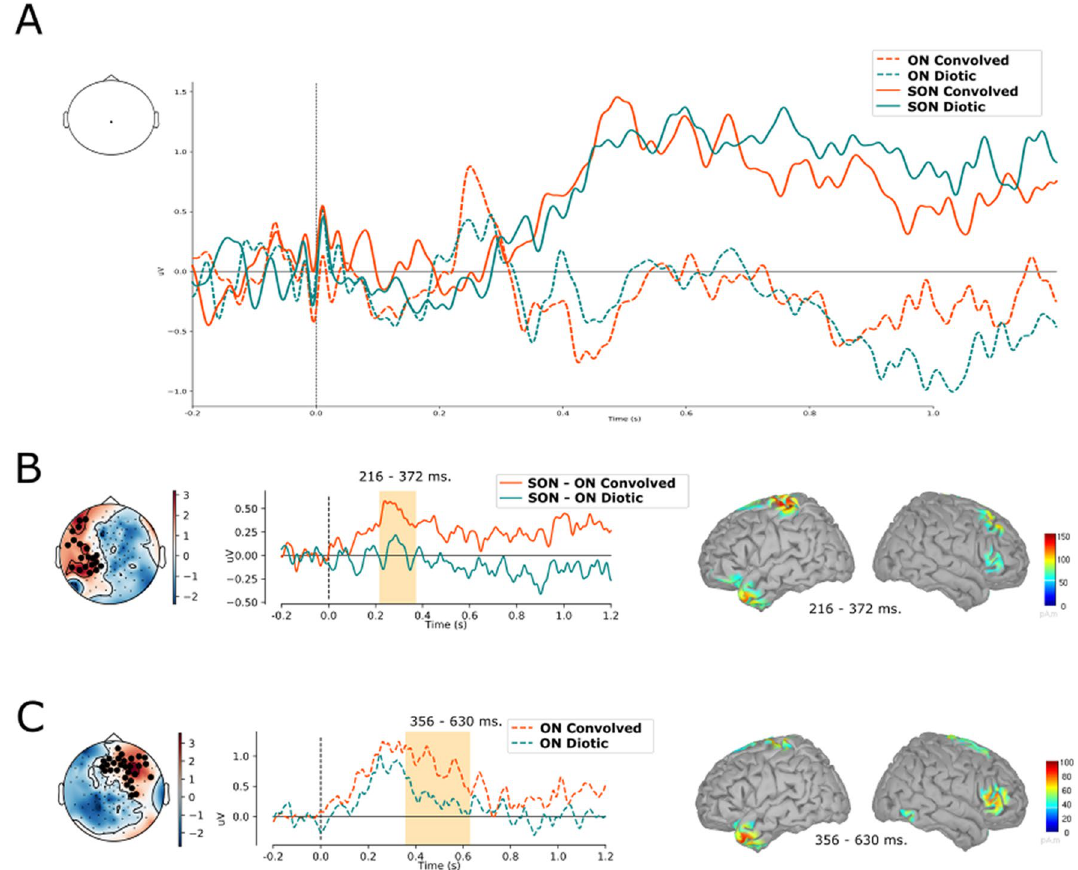
Figure 2. Comparison of evoked responses. (A) Comparison of evoked responses within the group of healthy subjects in convolved (red) and diotic (teal) conditions after self-relevant (solid lines: subjects own name) or irrelevant stimuli (dotted lines; other names). (B) Comparison of differences between own and other names between convolved and diotic conditions (SONc-ONc vs SONd-ONd). (C) Comparison of the other name between convolved and diotic conditions (ONc vs ONd). Significant clusters after spatiotemporal cluster permutation testing are indicated by black electrodes on each averaged map (within the timeframe of significance). ERP traces are averaged activity within significant clusters of electrodes, and significant timeframe is indicated with orange. Source localisation represents these differences within the timeframe of this